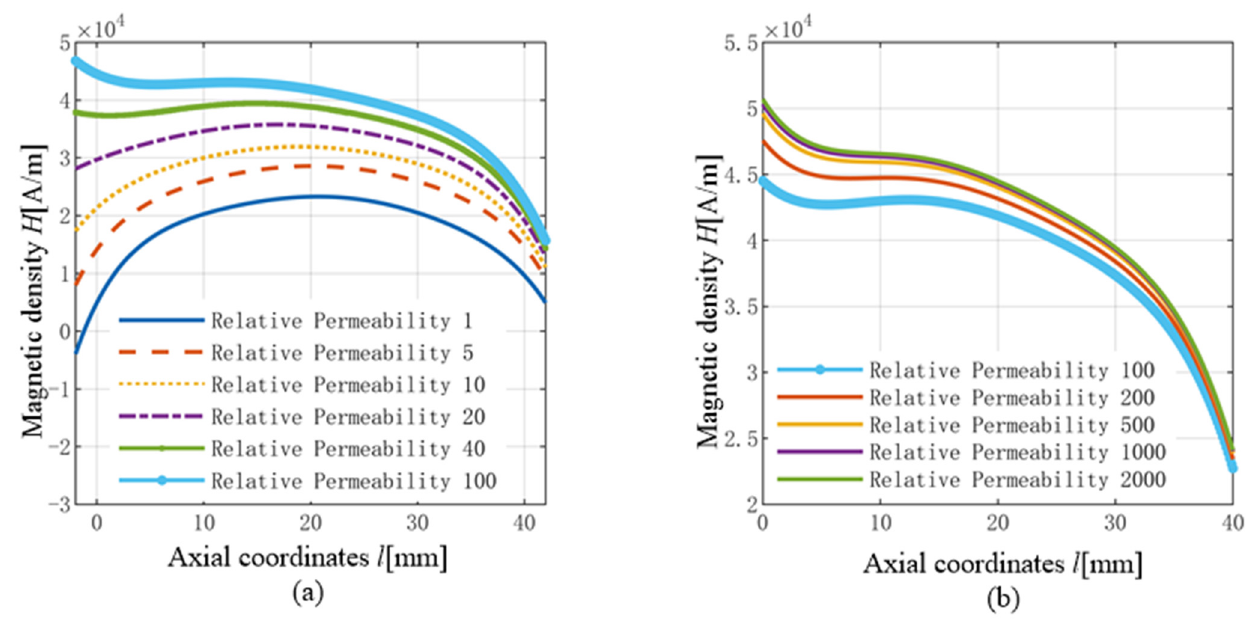
Figure 13. The axial magnetic density distribution of the GMM cylinder by changing the relative permeability of the shell. ( a ) u r =1, 5, 10, 20, 40, 100, ( b ) u r =100, 200, 500, 1000, 2000.